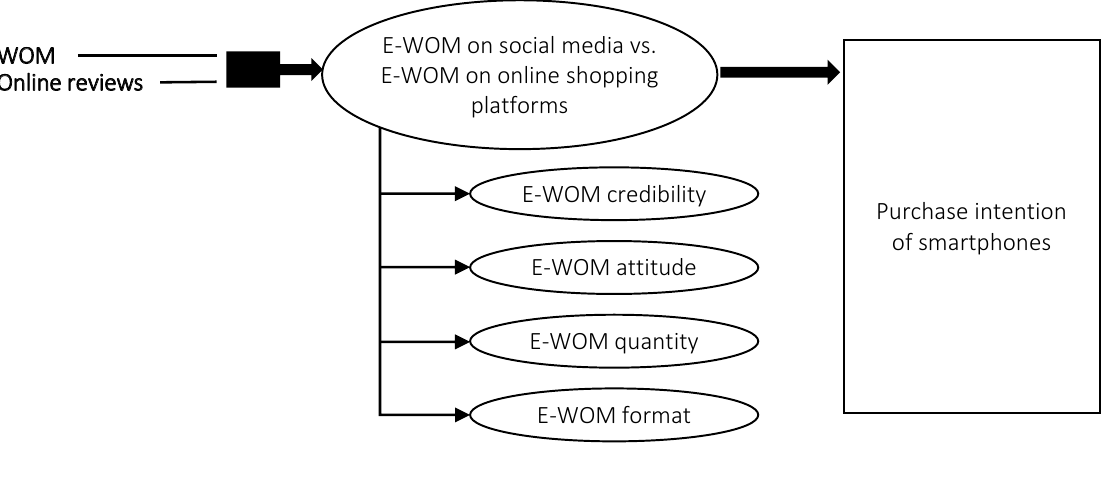
Figure 1. Research